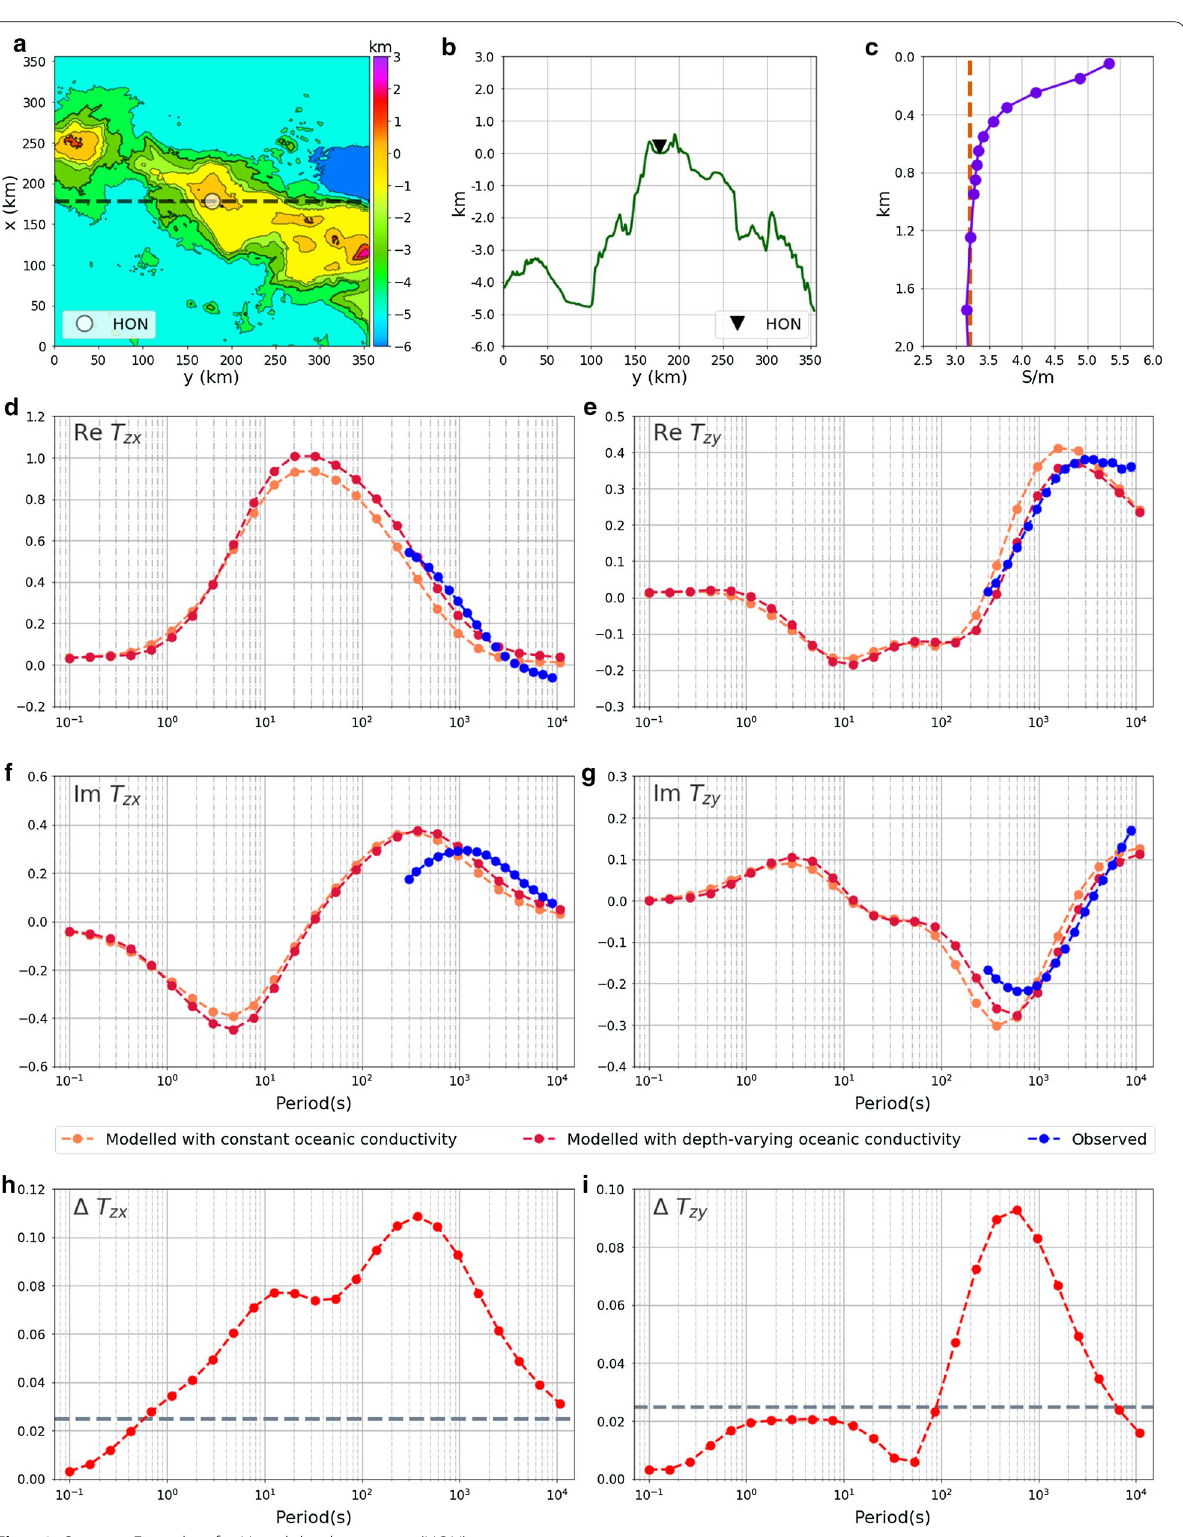
Fig. 10 Same as Fig. 5, but for Honolulu observatory